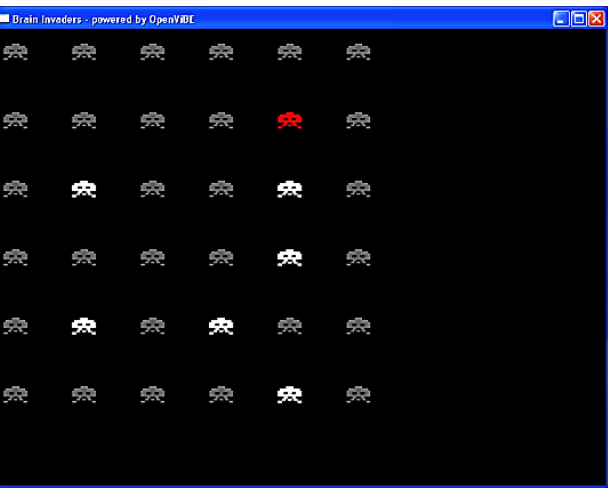
Figure 4. Interface of Brain Invaders at the moment at which a group of six NON-TARGET symbols flashed (in white). The red symbol is the TARGET. The NON-TARGETs that did not flash are in gray. Figure reused from [50].